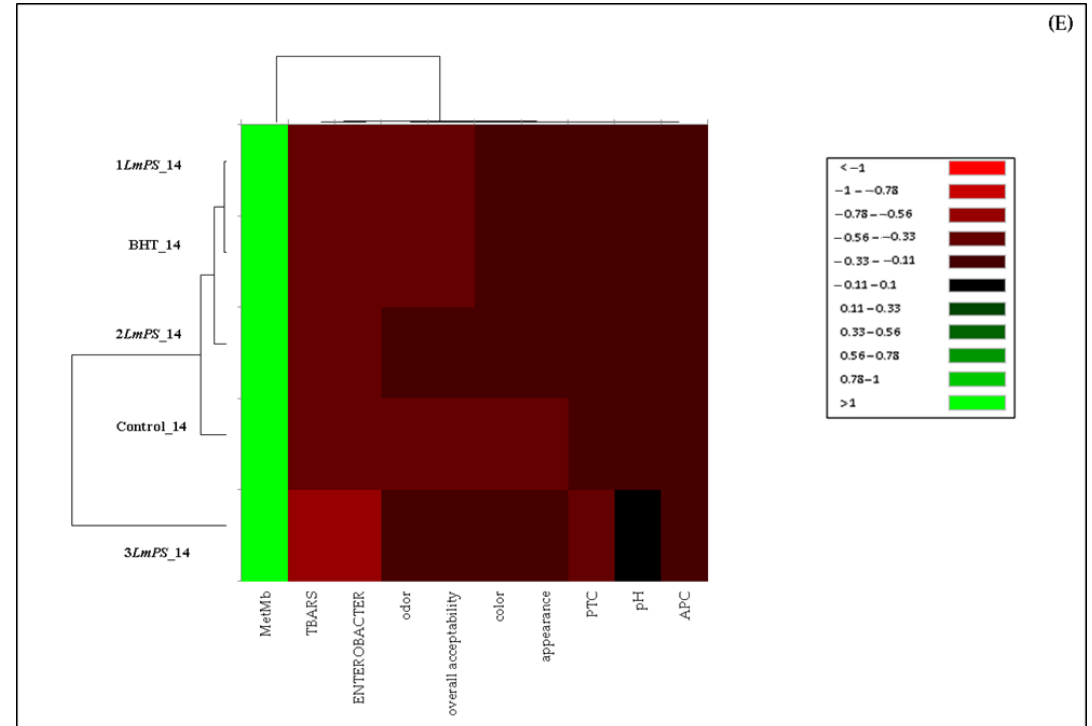
Figure 4. Two-way hierarchical cluster analysis (HCA) of physicochemical, microbial, and sensory characteristics of the control, BHT and different treated samples at each of the storage times: ( A ) day 0; ( B ) day 3; ( C ) day 7; ( D ) day 10 and ( E ) day 14.